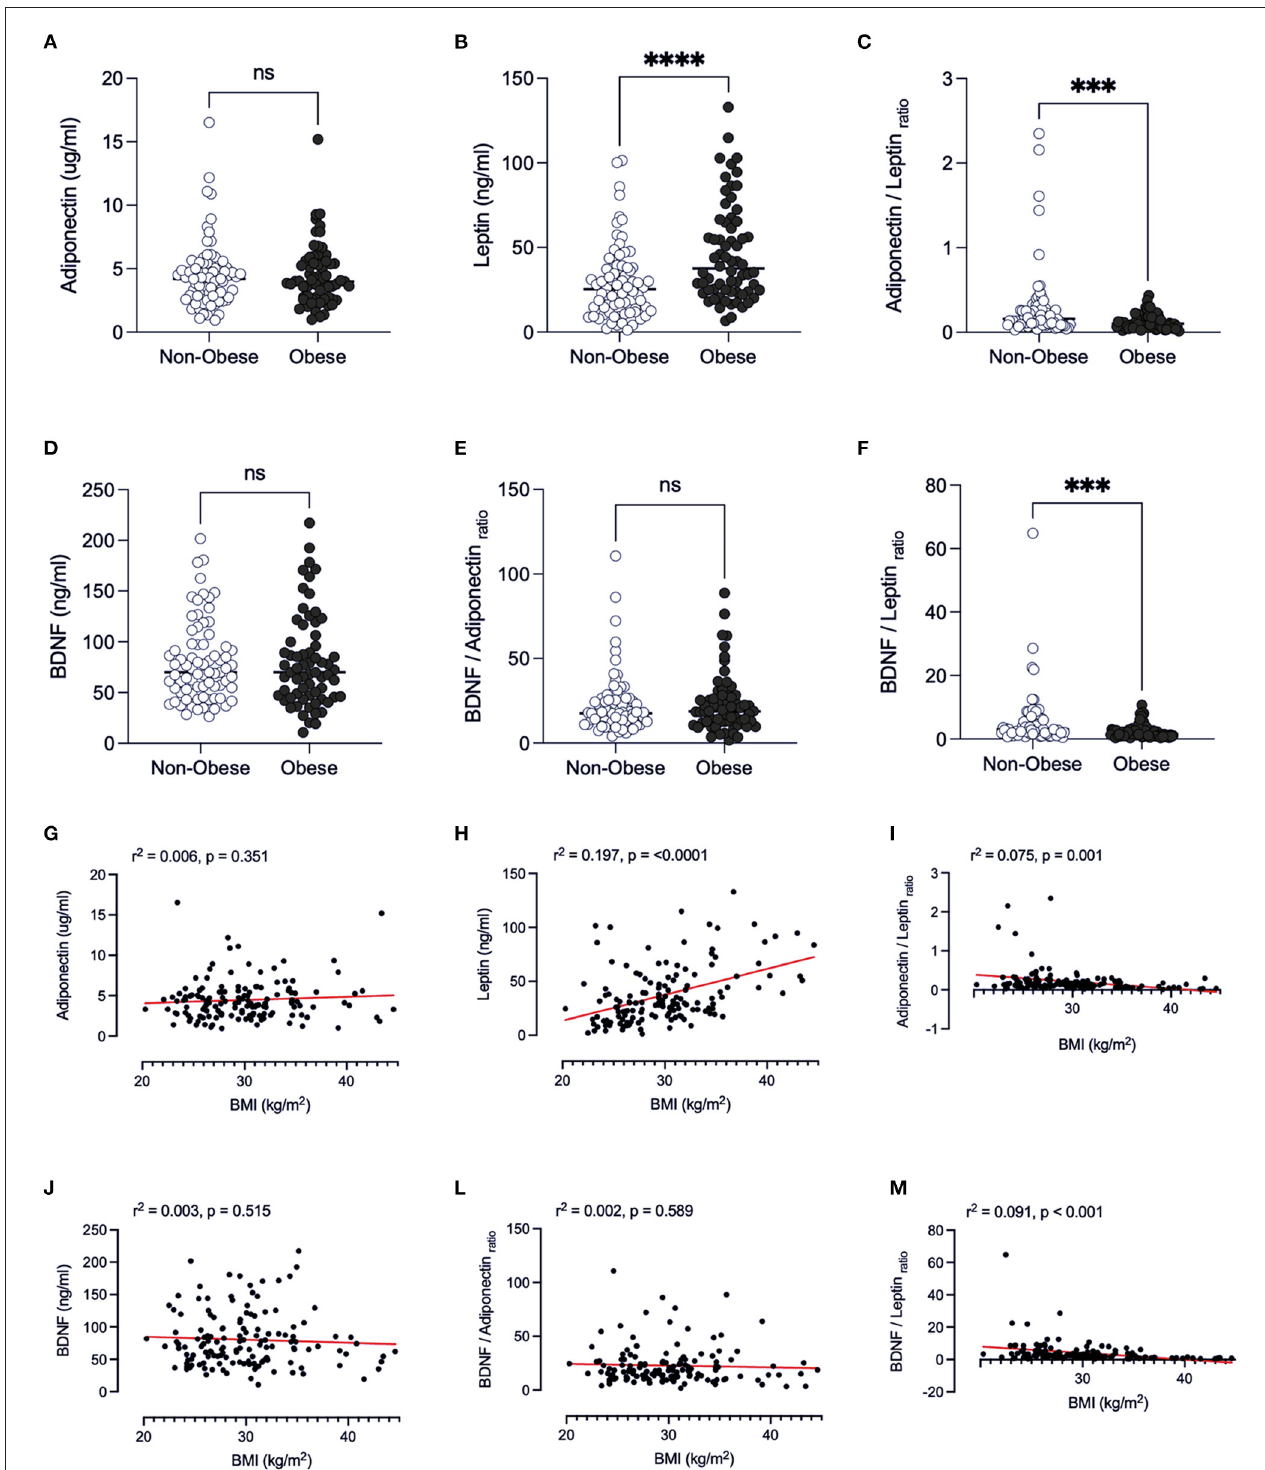
FIGURE 1 | Comparison of adipose-derived hormones levels between non-obese and obese patients with Covid-19. Values expressed as median of adiponectin (ug/ml) (A) , leptin (ng/ml) (B) , adiponectin/leptin ratio (C) , BDNF (ng/ml) (D) , BDNF/Adiponectin ratio (E) , BDNF/Leptin ratio (F) , BDNF / Adiponectin/Leptin ratio (G) were compared between two groups. Dashed box presents Linear regression curve of adiponectin (G) , leptin (H) , adiponectin/leptin ratio (I) ; BDNF (J) , BDNF/Adiponectin ratio (L) , BDNF/Leptin ratio (M) as dependent variable (Y axis) with body index mass (BMI) as independent variable (X axis). Significance: *** p < 0.001; **** p <